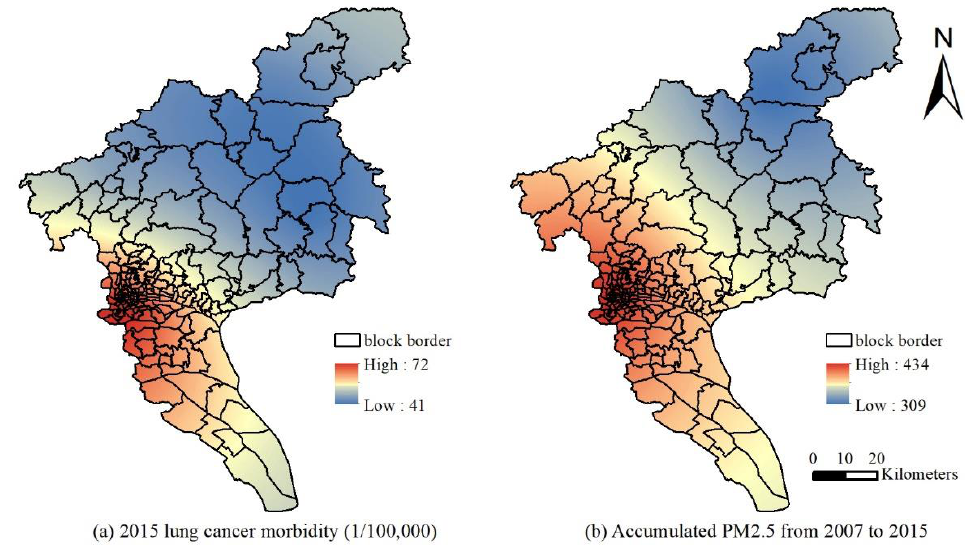
Figure 9. Spatial distribution of lung cancer incidence in 2015 and the total concentration of PM 2.5 in